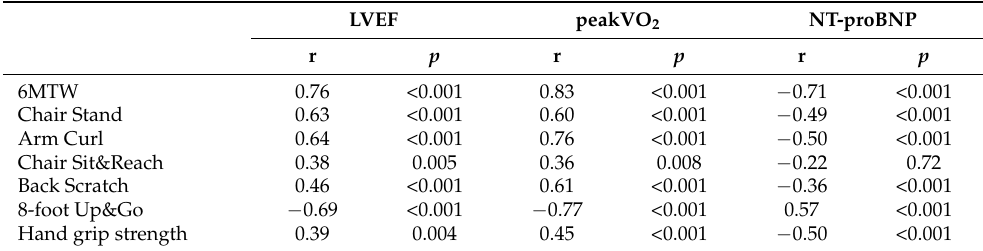
Table 4. The correlation between the Fullerton functional fitness test results including handgrip strength with LVEF, peakVO 2 and NT-proBNP values. LVEF peakVO 2 NT-proBNP r p r p r p 6MTW 0.76 <0.001 0.83 <0.001 − 0.71 <0.001 Chair Stand 0.63 <0.001 0.60 <0.001 − 0.49 <0.001 Arm Curl 0.64 <0.001 0.76 <0.001 − 0.50 <0.001 Chair Sit&Reach 0.38 0.005 0.36 0.008 − 0.22 0.72 Back Scratch 0.46 <0.001 0.61 <0.001 − 0.36 <0.001 8-foot Up&Go − 0.69 <0.001 − 0.77 <0.001 0.57 <0.001 Hand grip strength